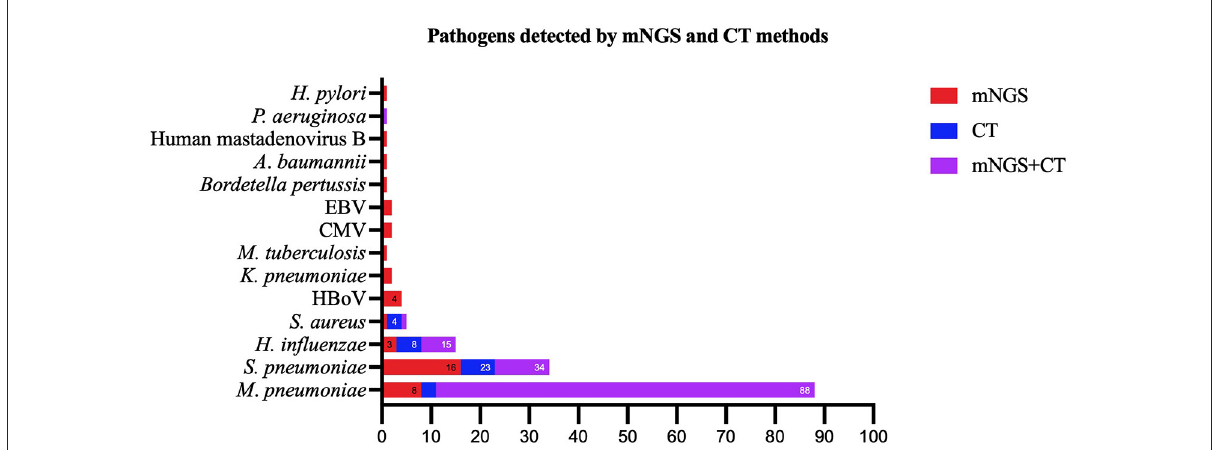
FIGURE4 Pathogens identified using both the metagenomic next generation sequencing (mNGS) and conventional tests (CT) methods, mNGS only, and CT methods only. mNGS, metagenomic next generation sequencing; CT, conventional test, HBoV, Human bocavirus; CMV, Cytomegalovirus; EBV, Epstein–Barr virus.